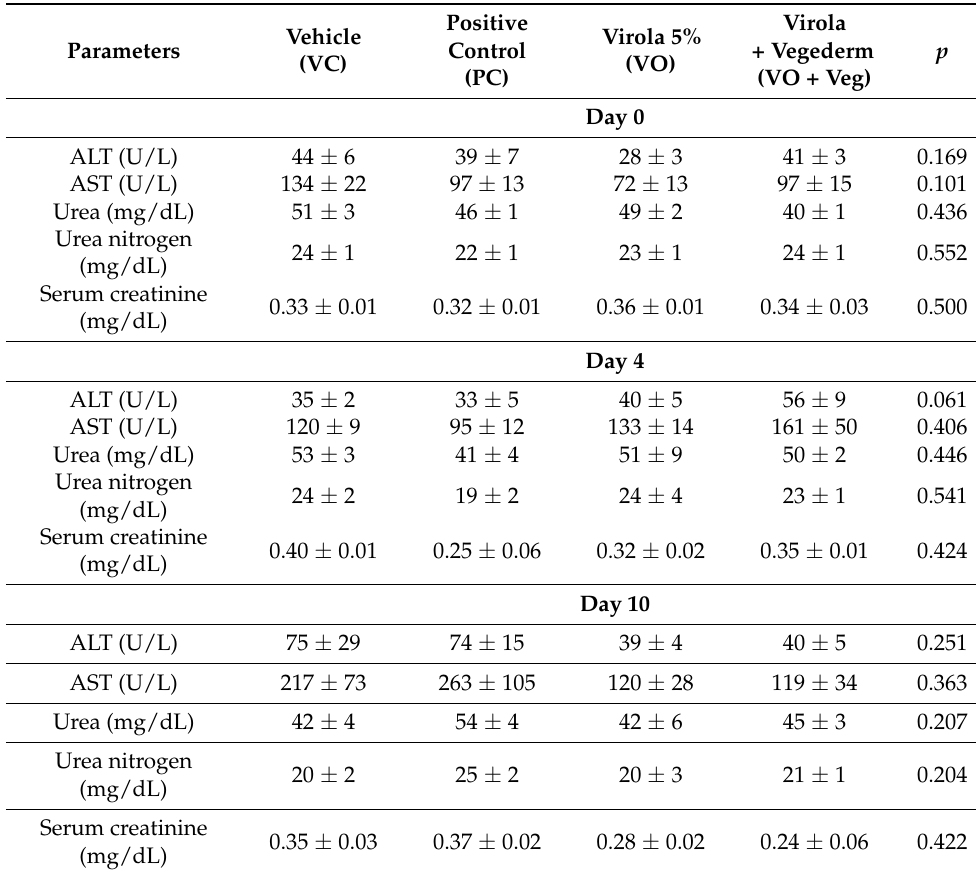
Table 2. Serum biochemical parameters in experimental healing groups of Wistar rats.